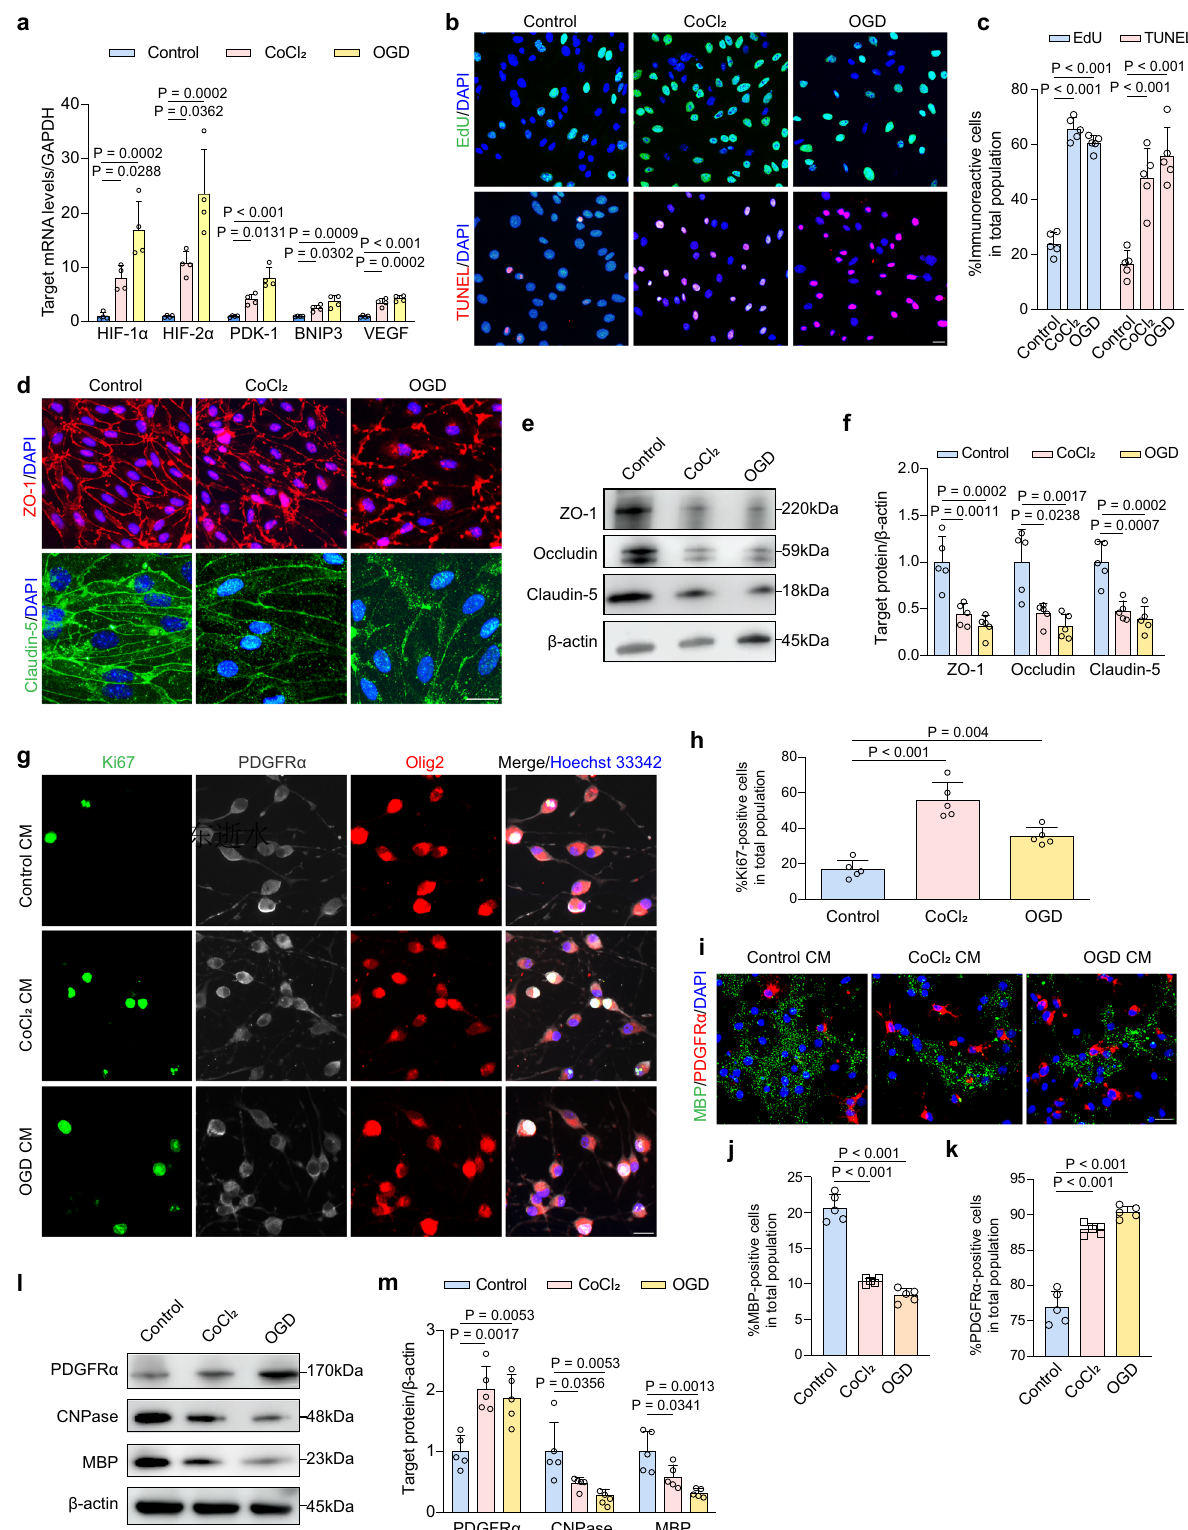
quanti fi cation demonstrated that chronic hypoxia did not affect the co-localization of Cav-1 and Cavin-1 in the membrane (Fig. S5g, h), further suggesting that hypoxia might not affect caveolar